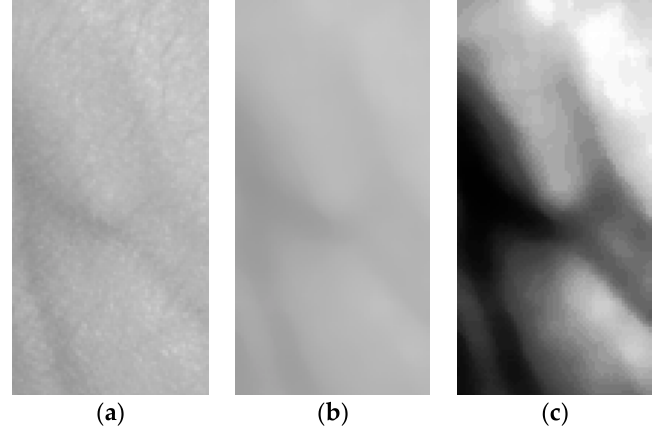
Figure 4. Process of bloodstream filtration: ( a ) before filtration (left), ( b ) after median filtration (middle), and ( c ) after equalization